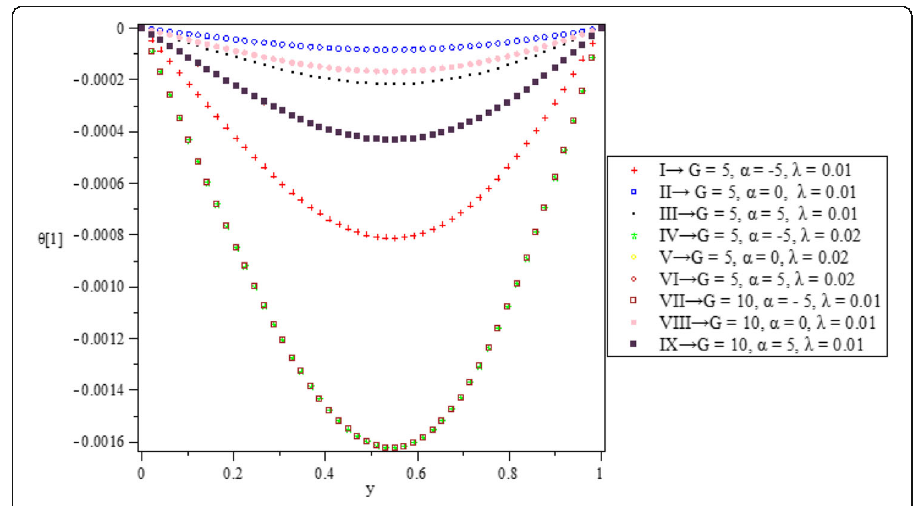
Fig. 29 First-order temperature ( θ [1] profile, r = − 1, ϵ = 0.25, P = 0.71, and β = 1.5)